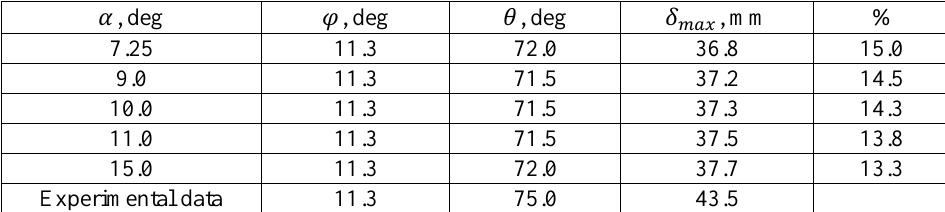
Table 2 . Maximum deflections of the mesh fabric under the different characteristics of pulling.